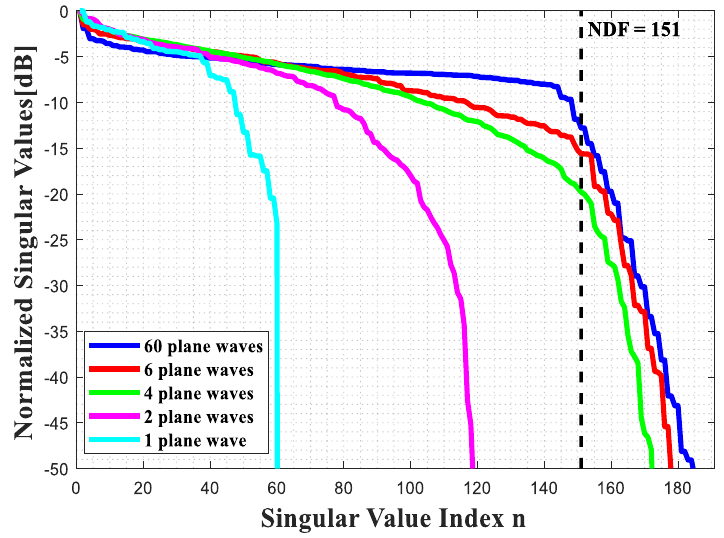
Figure 17. Comparison of the behavior of the normalized singular values of the linearized inverse scattering operator for various numbers of impinging plane waves for a double circumference ID.